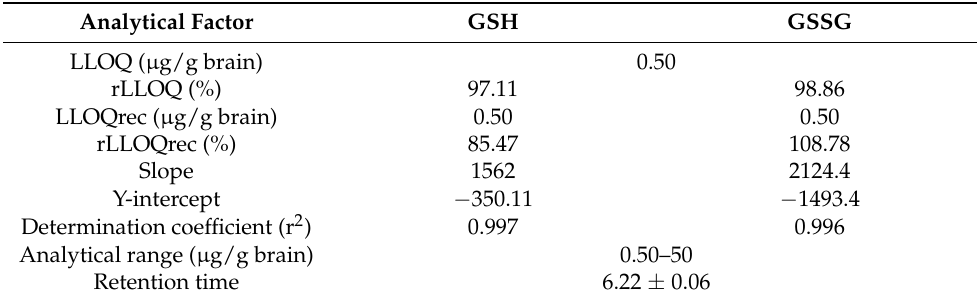
Table 2. Validation results of the analytical factors of HPLC method.